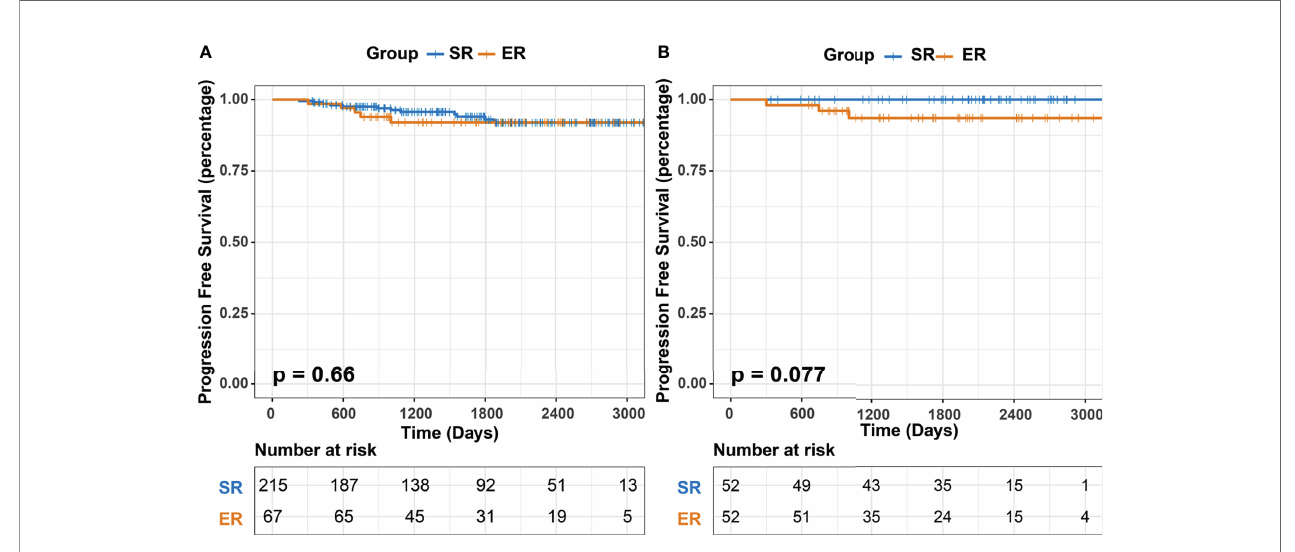
FIGURE 2 | Kaplan – Meier survival analysis of progression-free